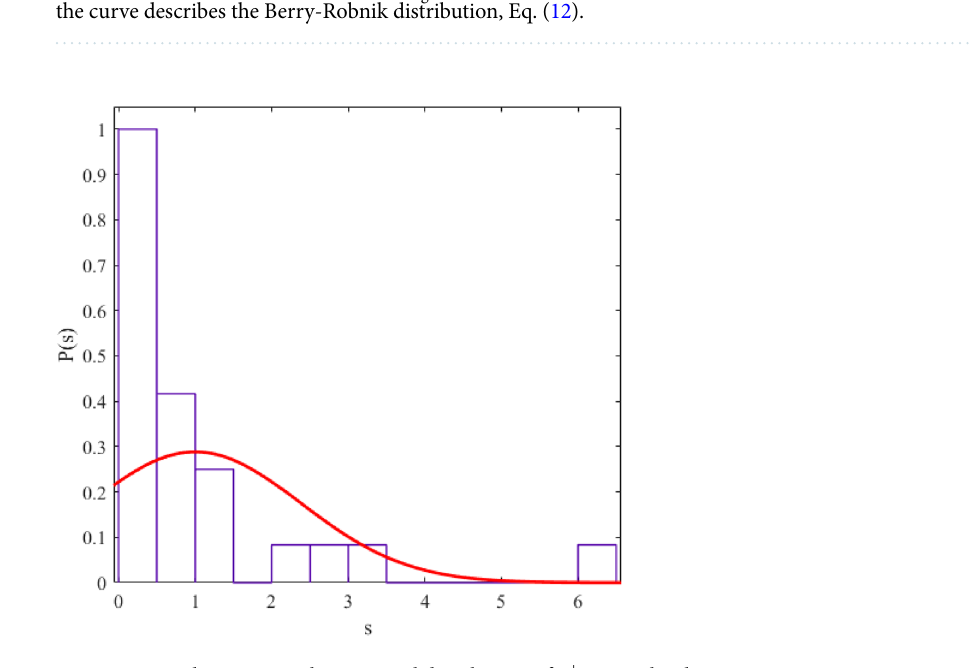
Figure 3. Similar to Fig. 1, the statistical distribution of 4 + g energy